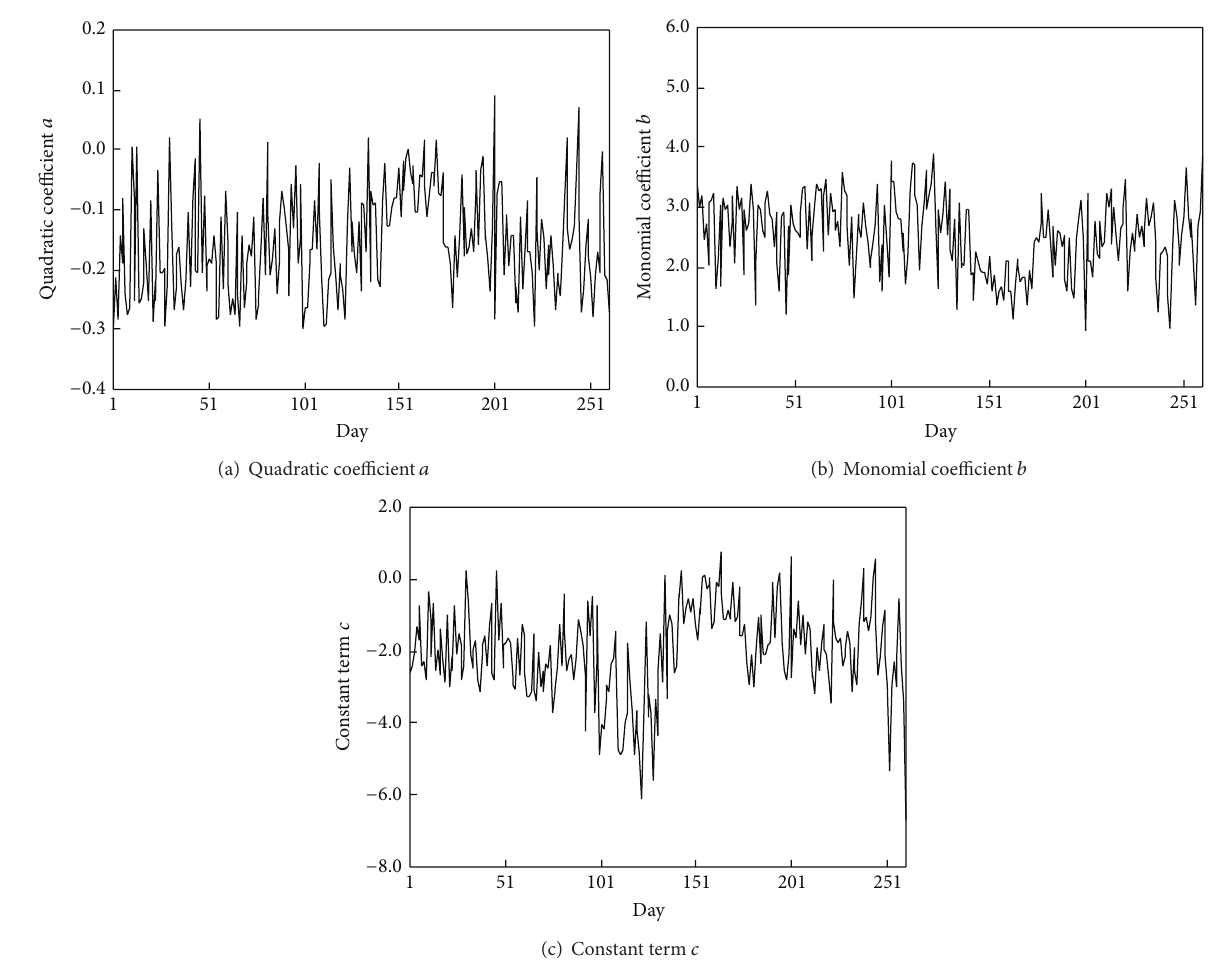
Figure 6: Long-term monitoring results of the fitted coefficients of the quadratic